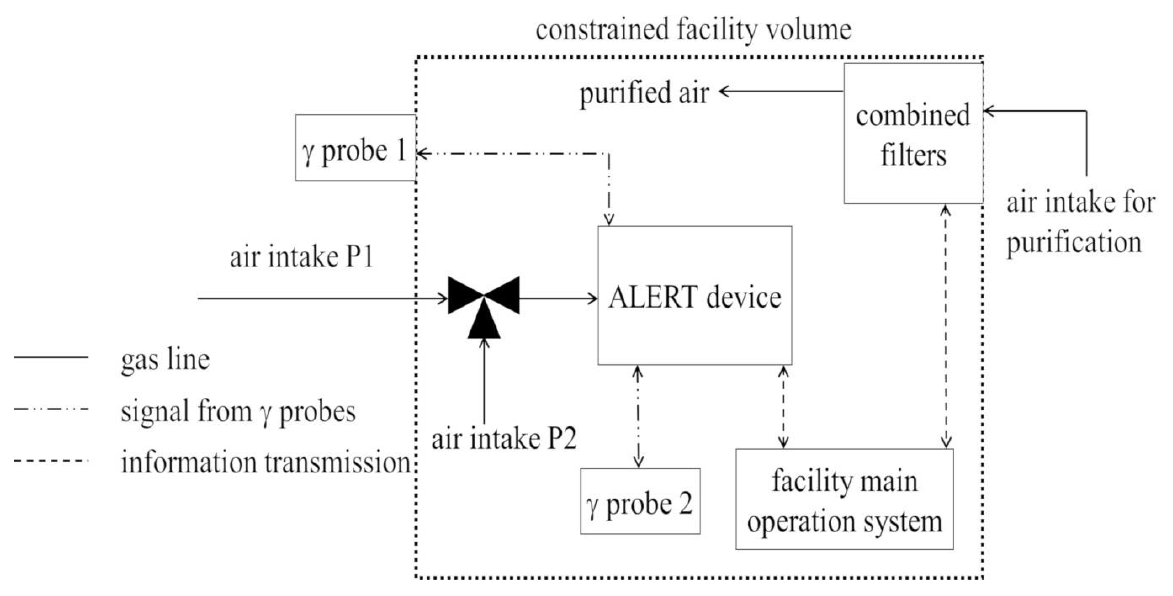
Figure 2. The scheme of a possible gas line option for the ALERT signaling device and the associated system location in the collective protection facility.